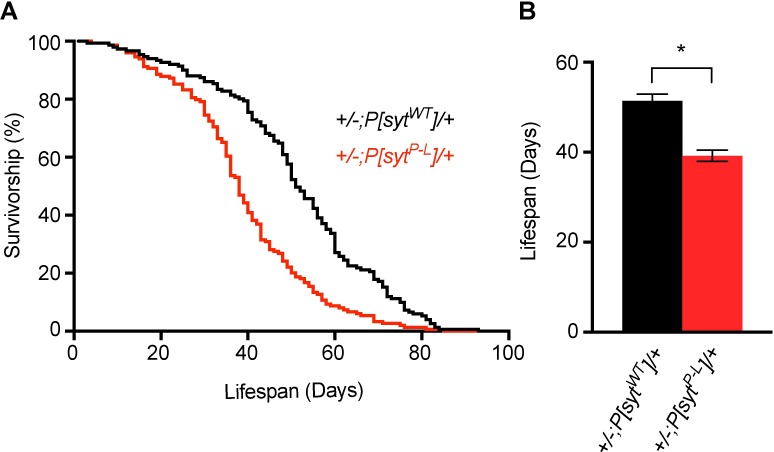
Lifespan is decreased in P[sytP-L] heterozygotes.(A) Adult lifespan curves of +/-;P[sytWT]/+ (n = 151, black) and +/-;P[sytP-L]/+ (n = 149, red). (B) Mean lifespan is significantly decreased in +/-;P[sytP-L]/+ adults (p < 0.0001, Wilcoxon Rank-Sum test).